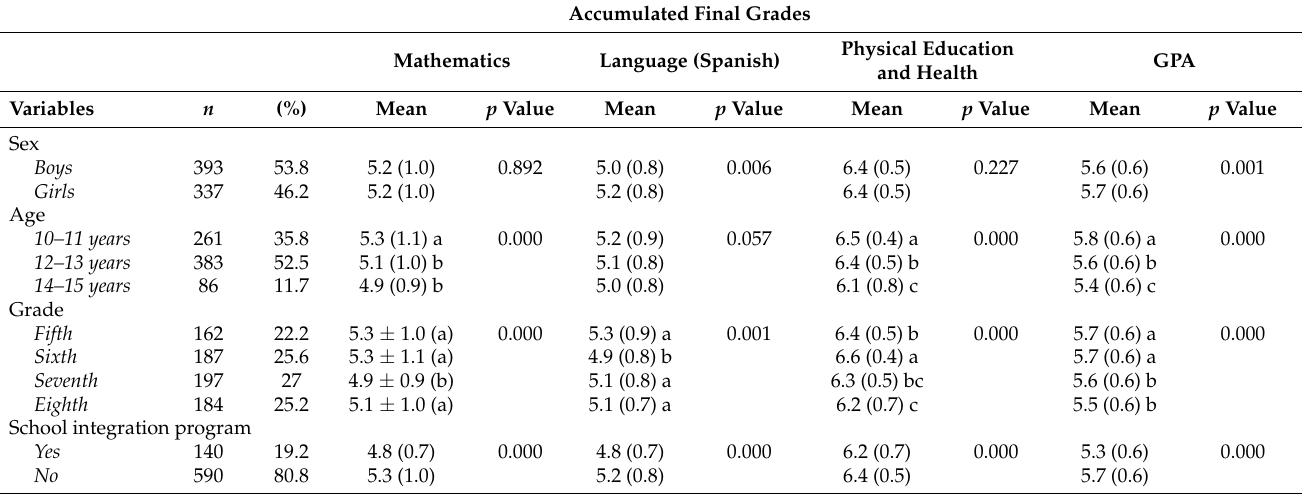
Table 1. Socio-educational characteristics according to the AFG and